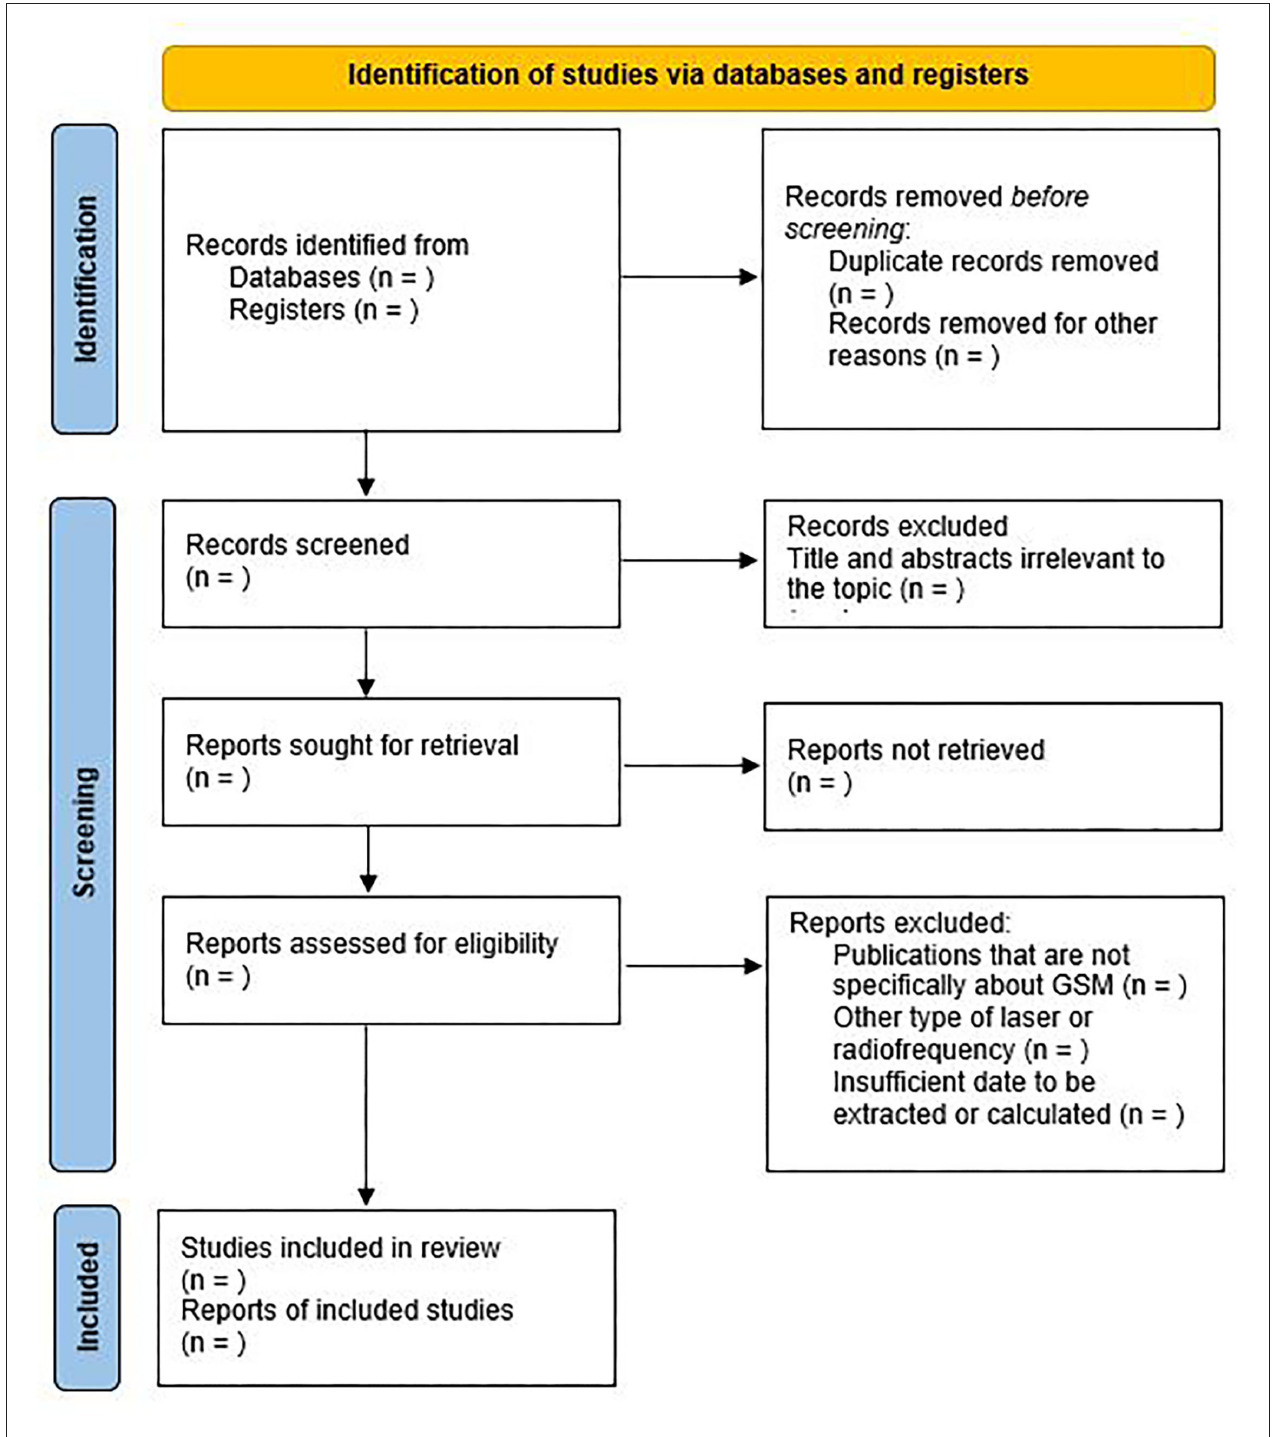
FIGURE 1 | PRISMA flow diagram for systematic review and meta-analysis.